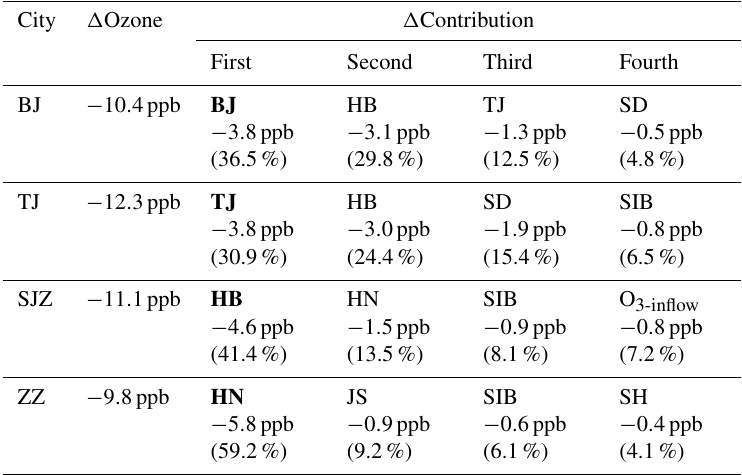
Table 4. The first four source regions from which ozone contribution changes the mean ozone concentration the most from 13:00 to 16:00LT in each city. Local region and source region where the city is located are denoted as